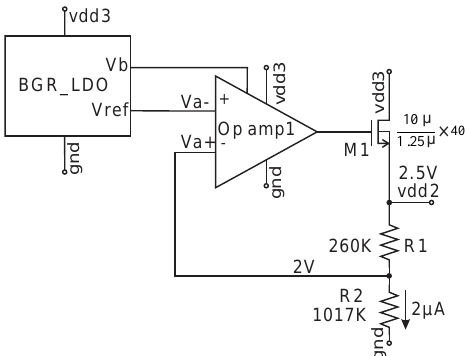
Figure 5. Schematic of the 2.5V high voltage (HV) low dropout (LDO).